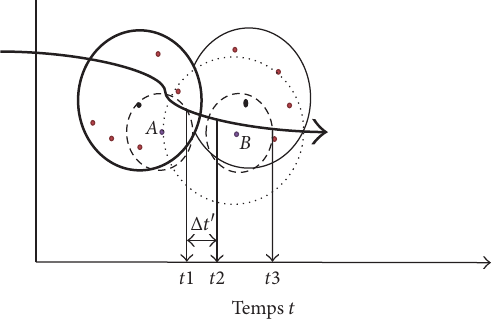
Figure 7: The problem of reflected wake waves.